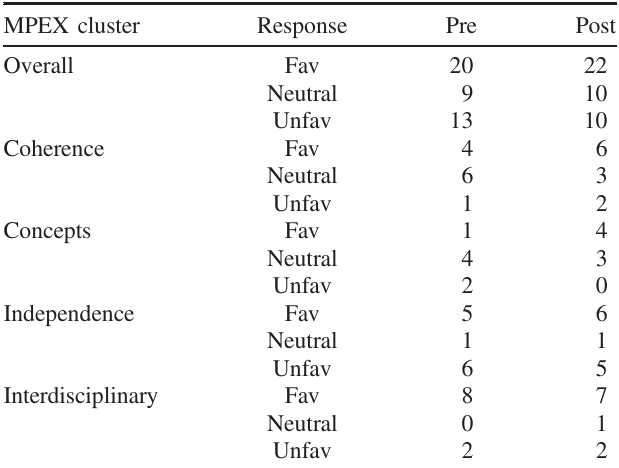
TABLE II. Phillip ’ s responses on the MPEX II and interdis- ciplinary cluster (42 items) from Pre (August 2012) to Post